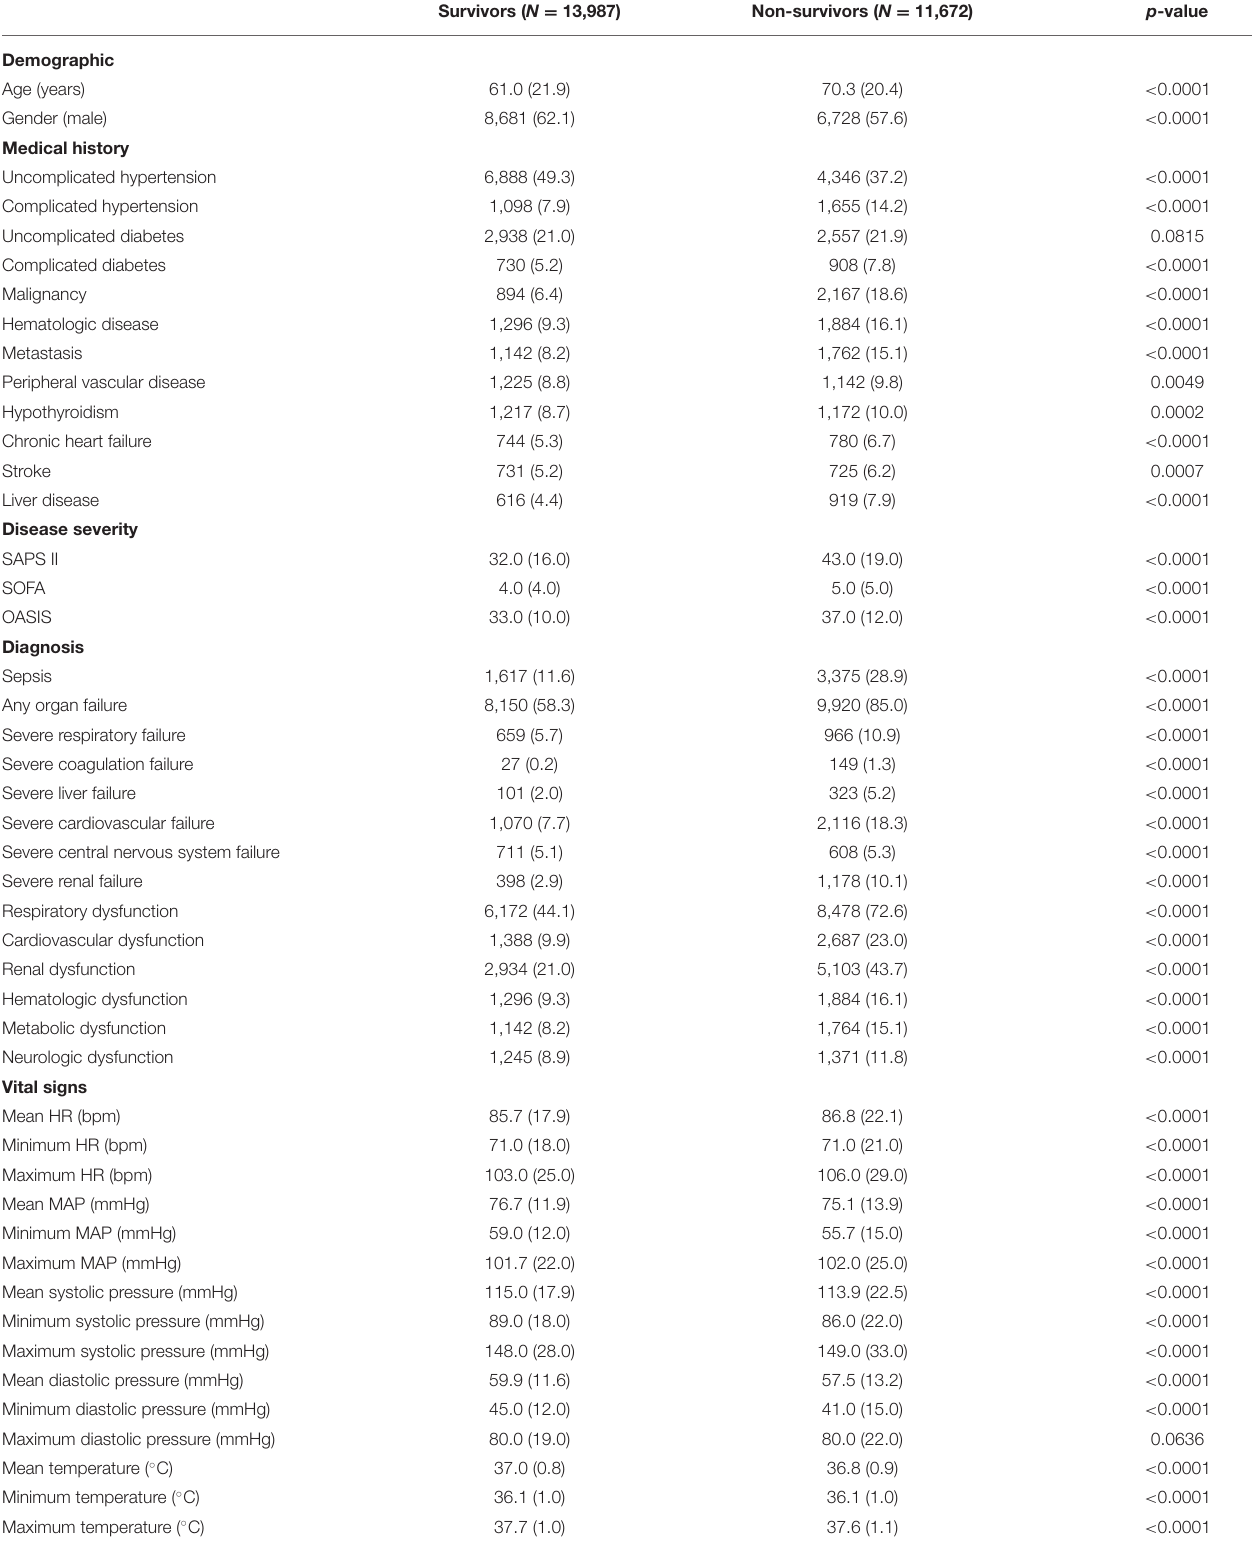
TABLE 1 | Characteristics between survivors and